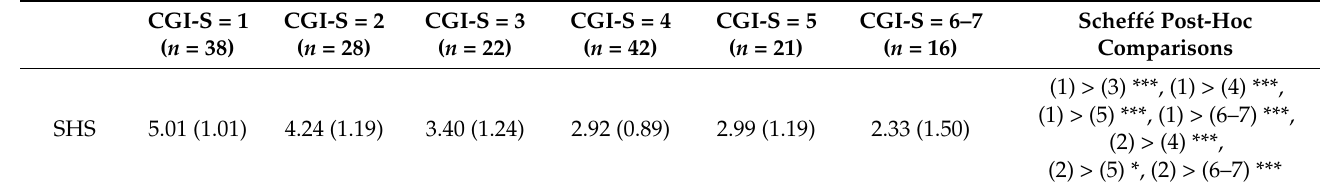
Table 2. SHS mean scores’ distribution according to depression severity levels as measured by the CGI-S ( n = 167). CGI-S =